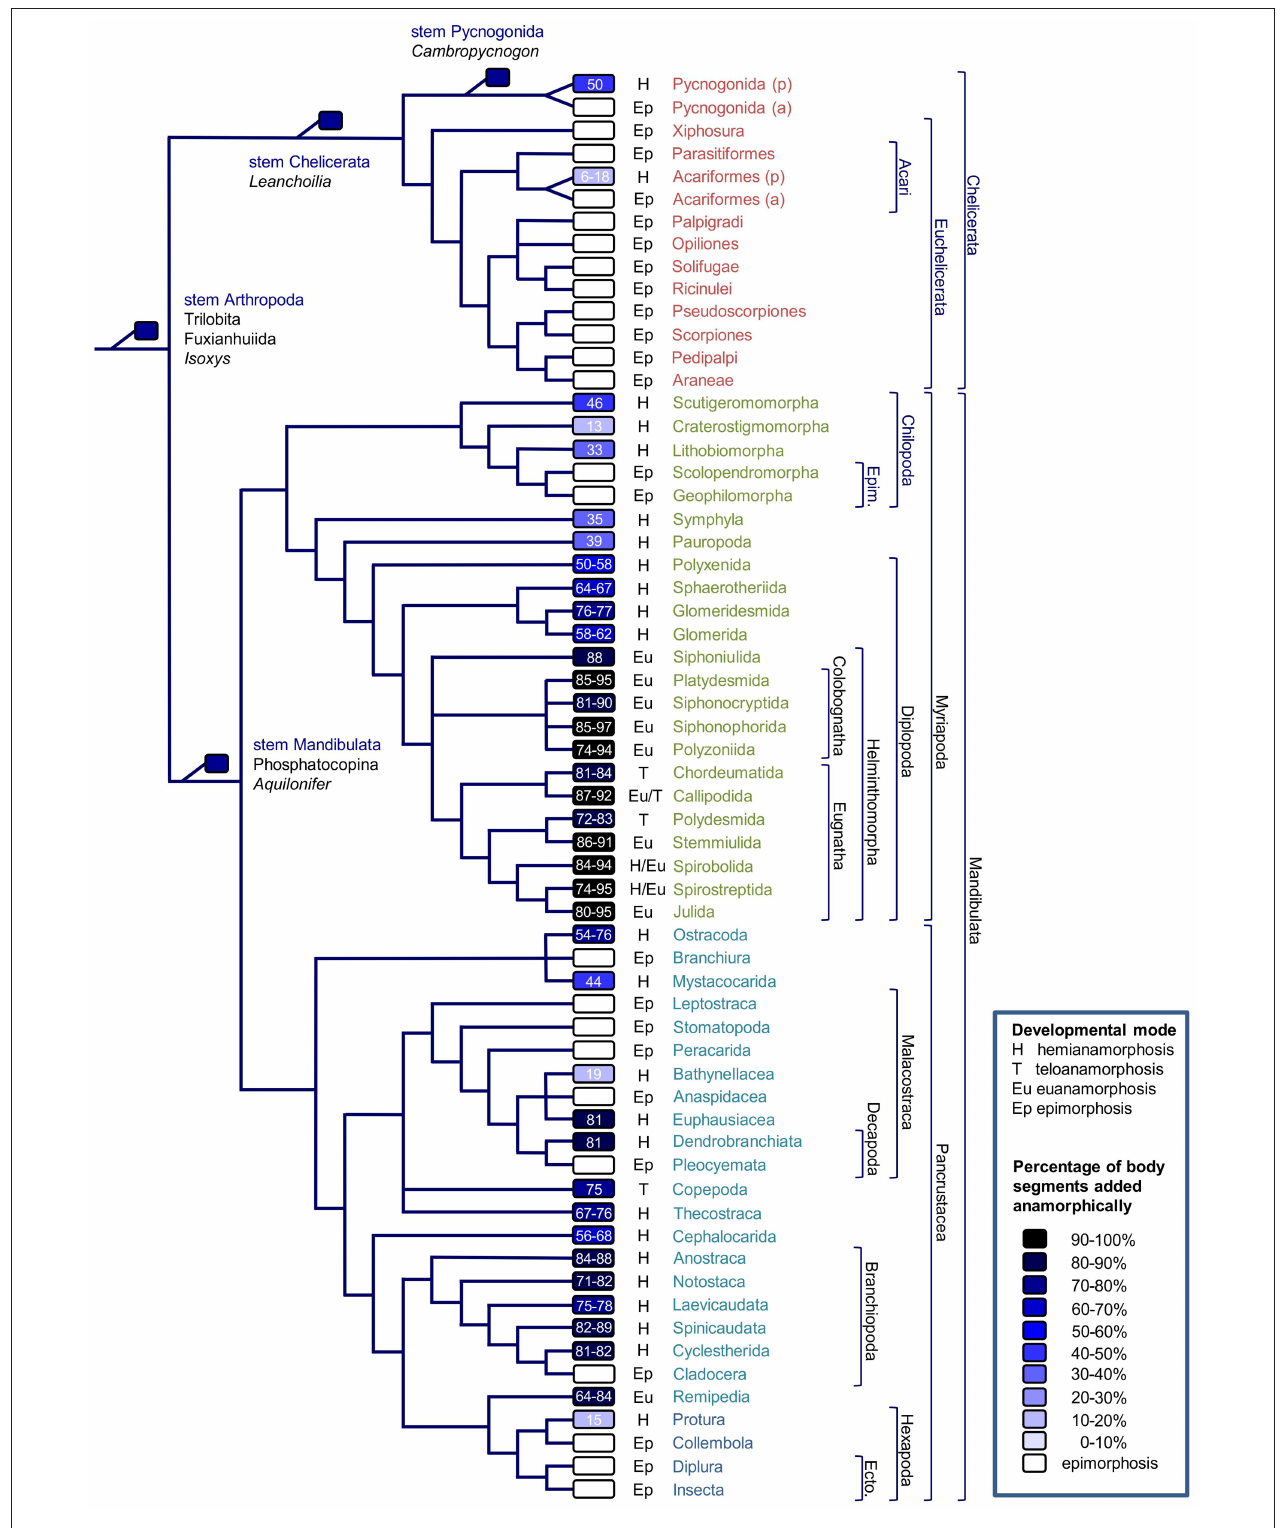
FIGURE 1 | Phylogenetic distribution of segmentation modes in arthropods. Phylogeny based on Giribet and Edgecombe (2019), Chipman and Edgecombe (2019) (fossils), Howard et al. (2020) (Chelicerata), Fernández et al. (2016) (Myriapoda), and Schwentner et al. (2018) (Branchiopoda and Malacostraca). p, plesiomorphic